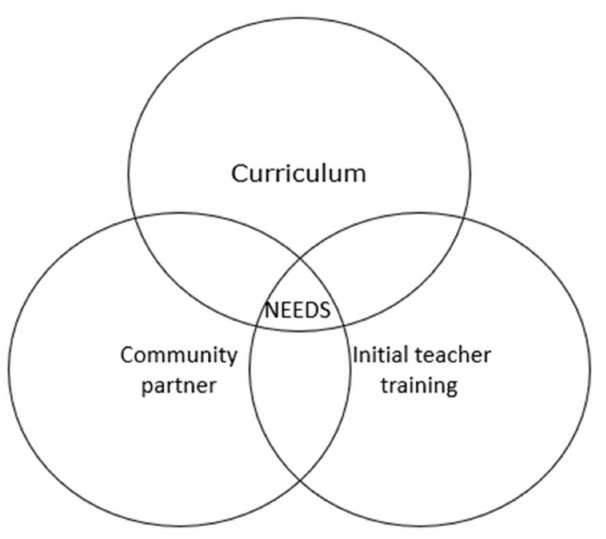
Figure 1. University–Community Partner relationship model. (Authors’